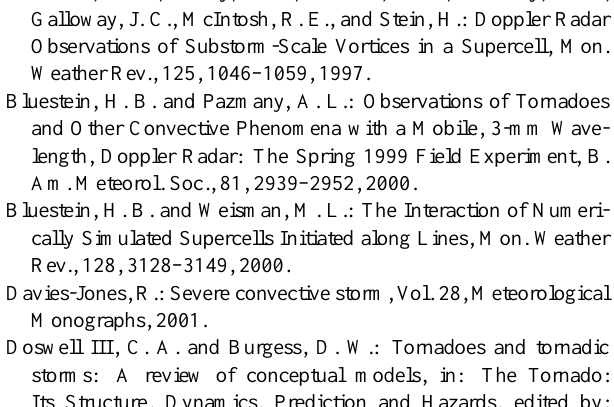
Figure 5. Profiles of velocity components with rotation, parameter values are the same as in Fig. 4.